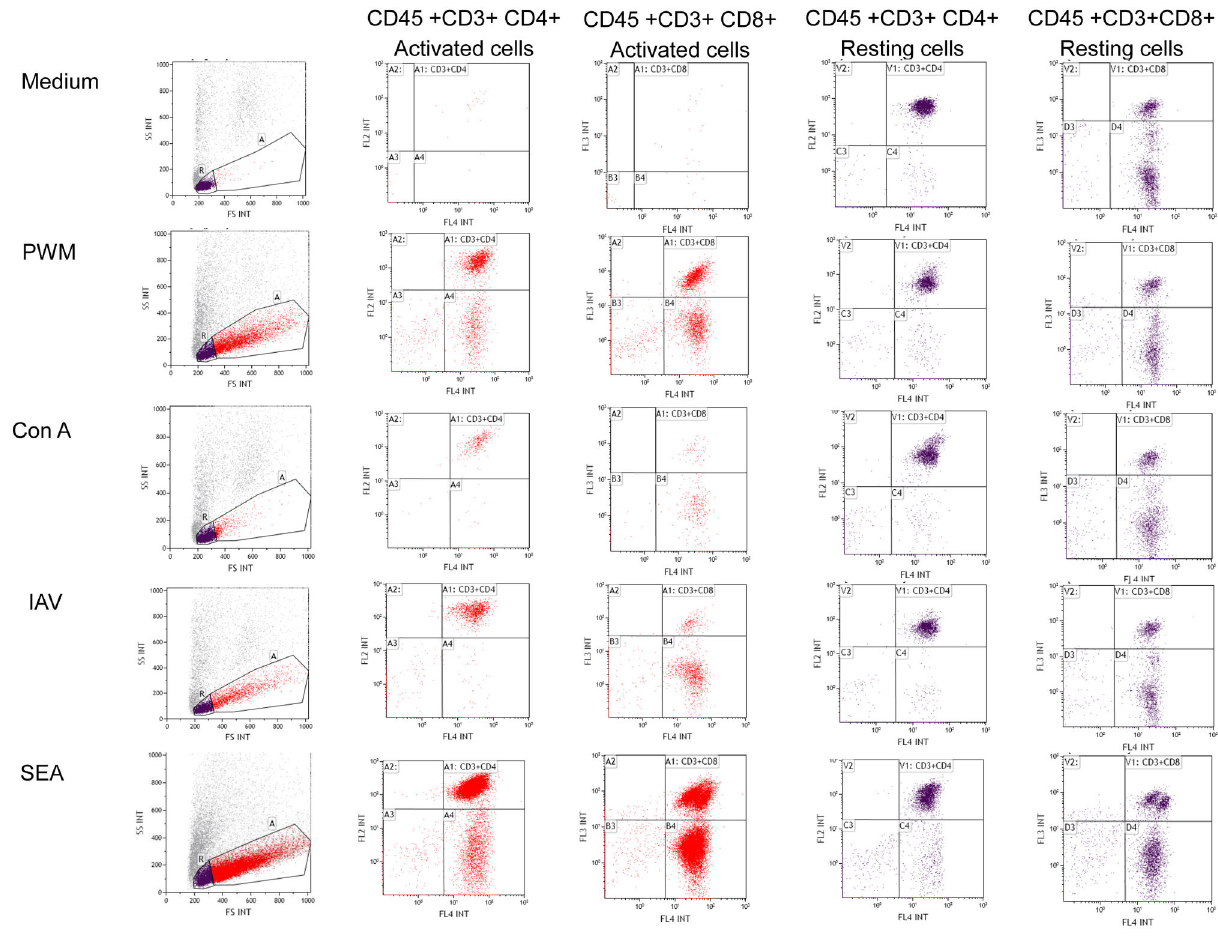
Figure 1. Flow-cytometric analysis of cell-mediated immune response in activated whole blood. The FITC-CD45+ resting and activated leukocytes from medium, Pokeweed mitogen-, Concanavalin A-, Influenza A vaccine- and Staphylococcus enterotoxin A-stimulated supernatants were gated according to their size and granularity on forward and side scatter plot (in region R and A respectively). The CD3+ CD4+ cells and CD3+ CD8+ cells were detected within the regions R and A accordingly.